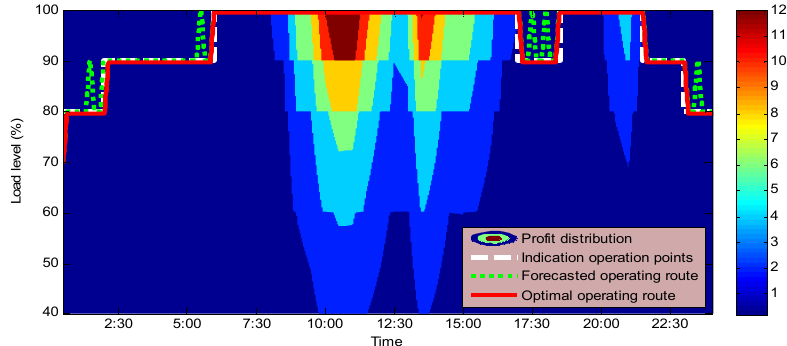
Figure 8. Profit distribution of the CHP.